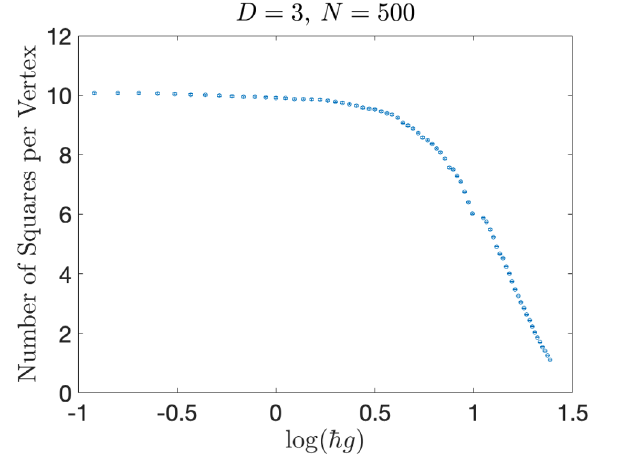
Figure 3 . Average number of squares per vertex as a function of the coupling constant g ~ for D = 3 . The maximum value for a cubic lattice is